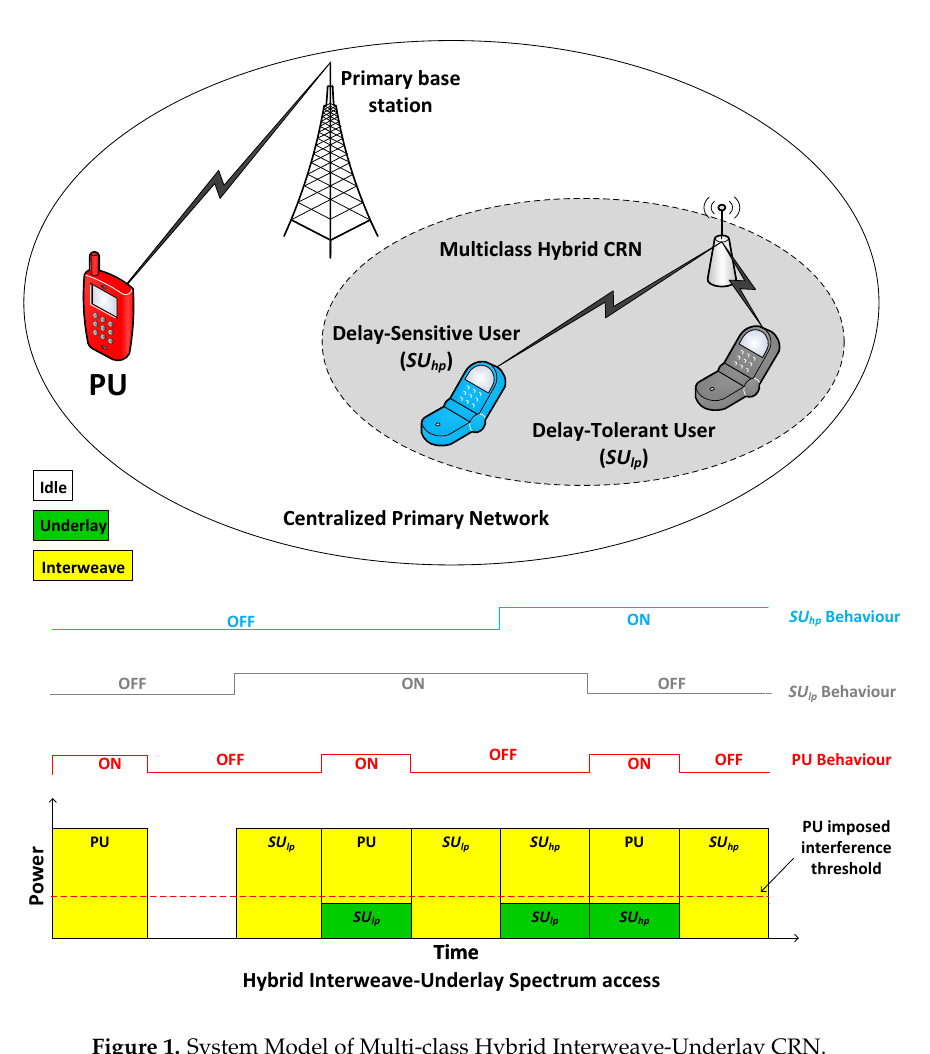
Figure 1. System Model of Multi-class Hybrid Interweave-Underlay